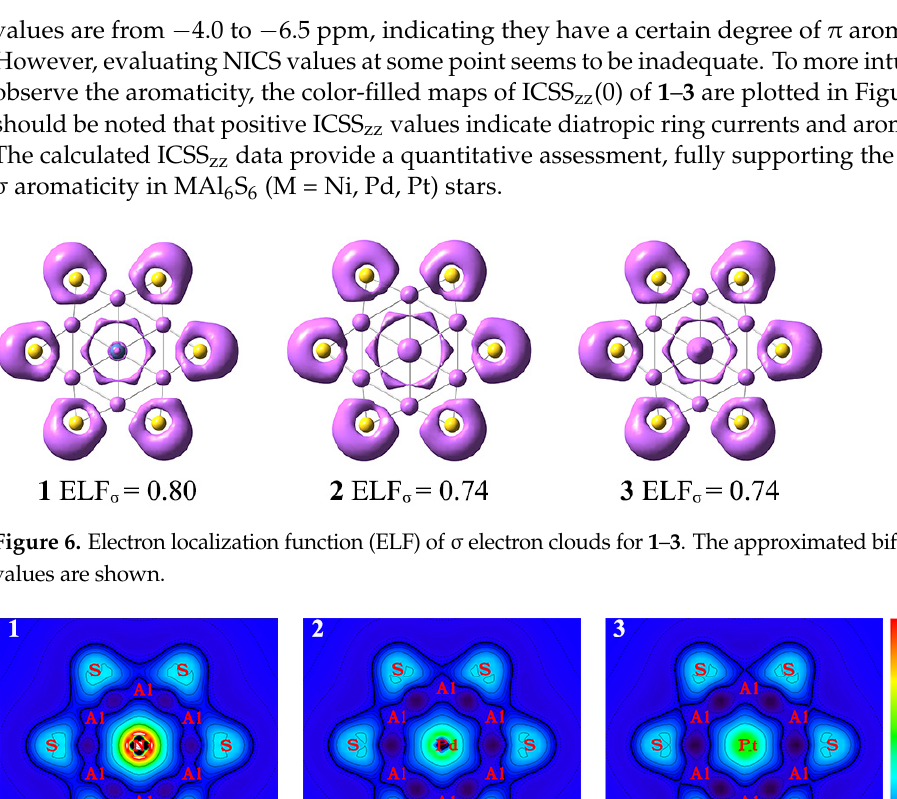
Figure 7. Color-filled maps of ICSS zz (in ppm) at the molecular plane for the 1 - 3 clusters. Positive values indicate aromaticity. values indicate aromaticity.